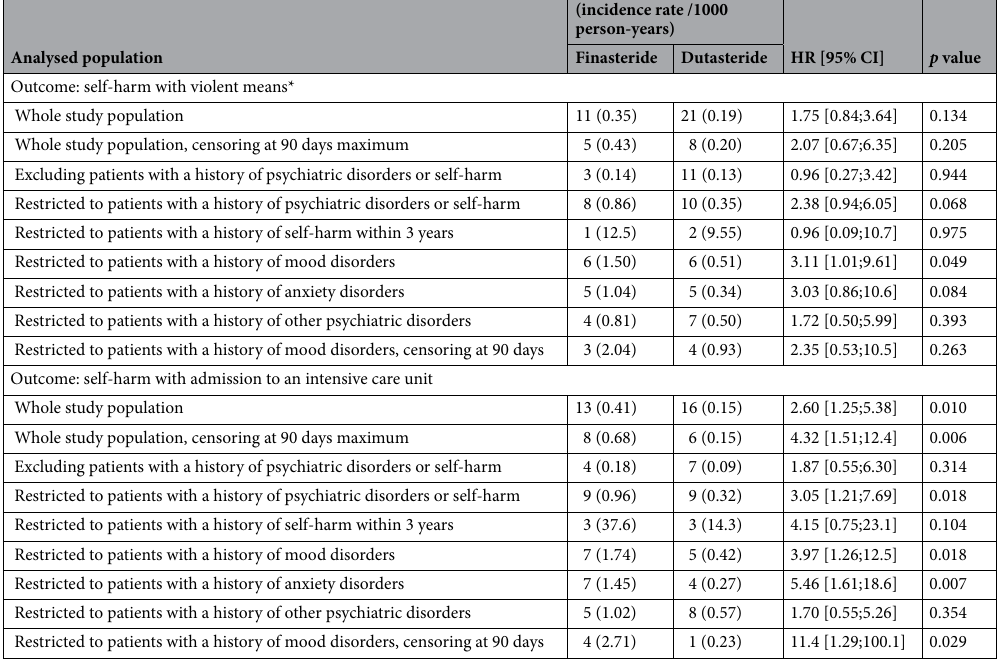
Table 3. Risk of self-harm by a violent means or admission to an intensive care unit associated with finasteride compared to that with dutasteride (IPTW adjusted analyses). Cox proportional hazards models controlled by IPTW for the following potential confounders: age, year of treatment initiation, pre-existing prostatic and psychiatric conditions and treatments, comorbidities used in the Charlson index. *Self-harm with a violent means defined by an ICD-10 code (X66-X83). CI: confidence interval. HR: hazard ratio. IPTW: inverse probability of treatment